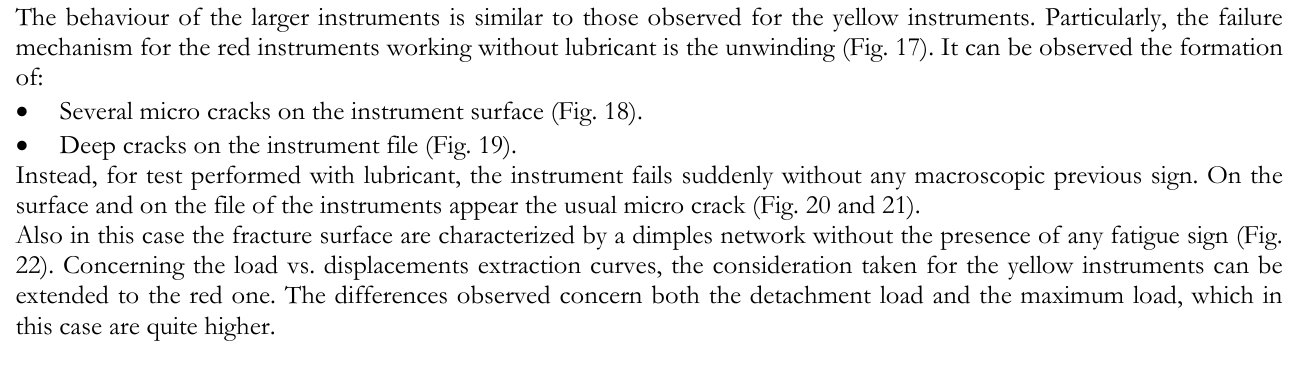
Table 4: Red instrument test